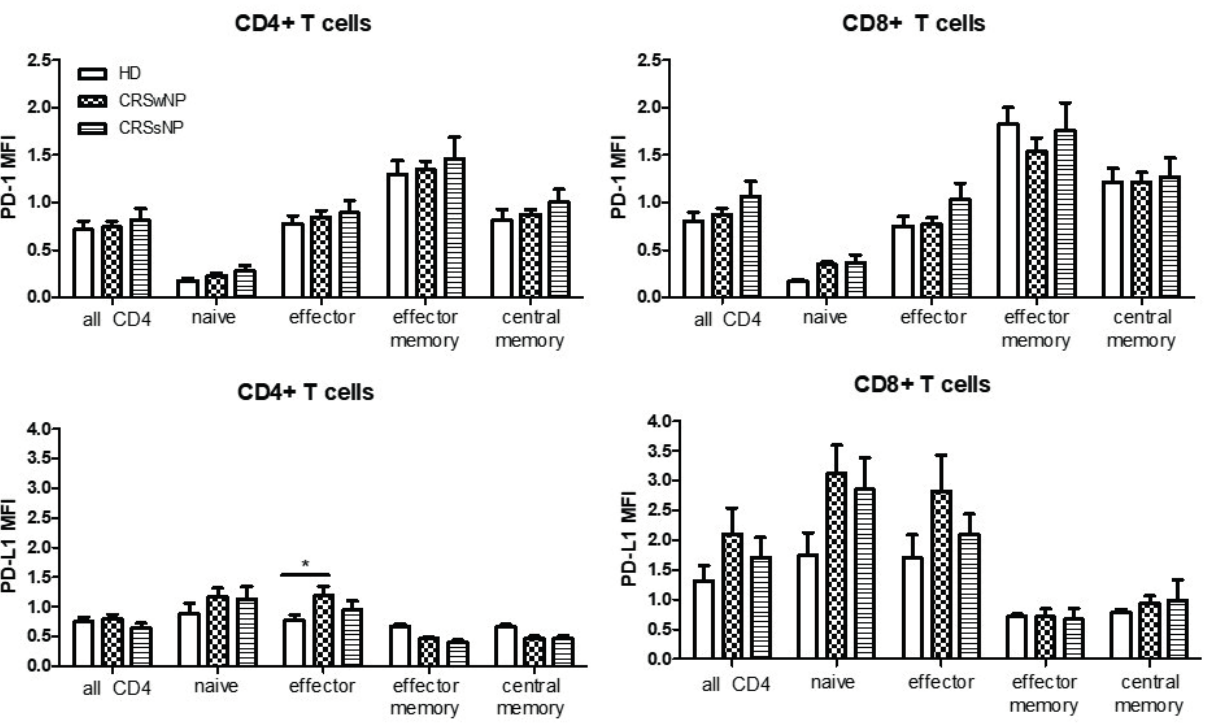
Figure 3. Flow cytometric analysis of PD-1/PD-L1 expression intensities (MFI) of CD4+ and CD8+ T-cell subsets in PBMC from CRSwNP (n = 38) and CRSsNP (n = 14) patients compared to healthy donors (n = 21). PD-1/PD-L1 expression intensities (MFI) of naïve, effector, effector memory and central memory T cells within CD4+ or CD8+ T cells as well as of CD4+ T helper cell subsets TH1, TH2 or TH17/22 are